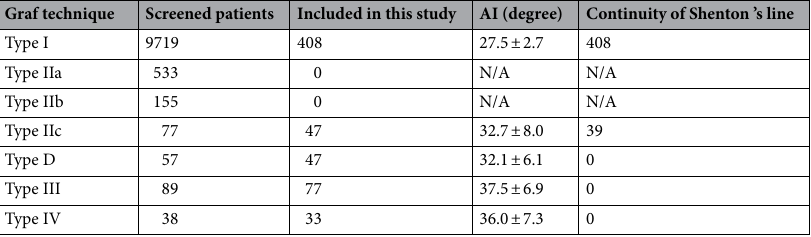
Table 3. Screening results according to the Graf technique. AI acetabular